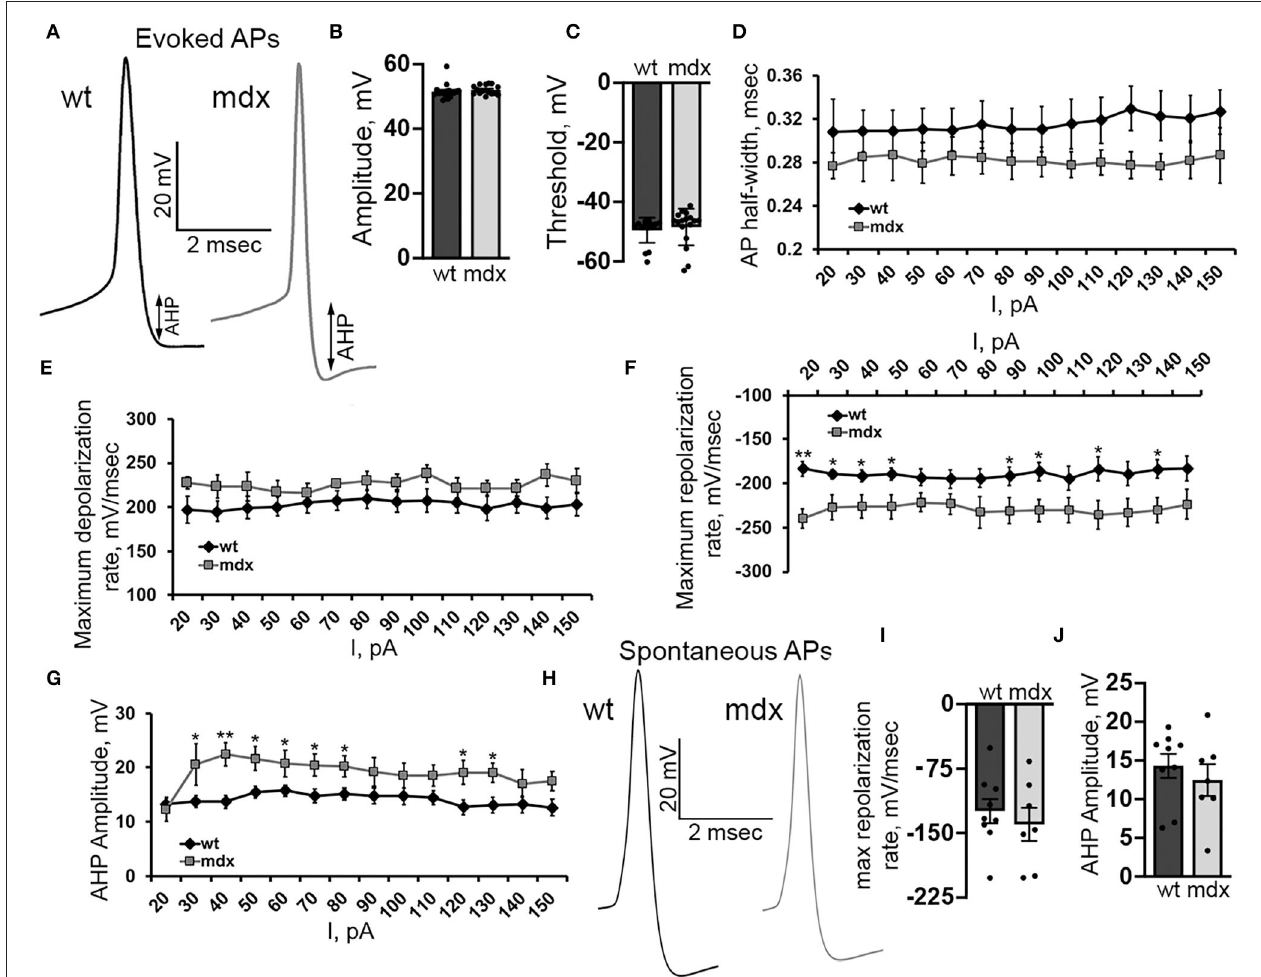
FIGURE 7 | Evoked AP repolarization rate and AHP are increased in mdx CbN neurons. (A) Representative traces of evoked AP waveforms from wild-type (black trace) and mdx (gray trace) YFP + CbN neurons. Arrows indicate AHP amplitude. Scale bar: 20mV, 2ms. (B,C) Summary graphs of mean AP amplitude (B) and threshold (C) from current clamped wild-type (dark gray bar, n = 9 cells from 3 animals) and mdx (light gray bars, n = 8 cells from 3 animals) YFP + CbN neurons. (D–G) Summary graphs of mean AP half width (D) , maximum depolarization rate (E) , maximum repolarization rate (F) , and mean AHP amplitude (G) plotted against current injection from wild-type (black diamonds, n = 9 cells from 3 animals) and mdx (gray squares, n = 8 cells from 3 animals) neurons. (H) Representative traces of spontaneous APs (no current injection through the patch pipette) recorded from wild-type (left, black trace) and mdx (right, gray trace) YFP + CbN neurons. Traces are averages of 200 action potentials. Scale bar: 20mV, 2ms. (I,J) Summary graphs of mean maximum repolarization rate (I) and AHP amplitude (J) of spontaneous APs in wild-type (dark gray bars, n = 9 cells from 2 animals), and mdx (light gray bars, n = 8 cells from 3 animals) neurons. Error bars indicate SEM. * p ≤ 0.05, ** p ≤